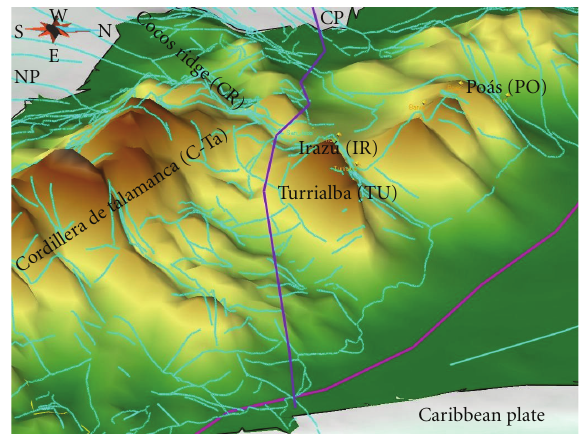
Figure 6: Perspective view onto the research area in Central America with some emphasis on the seafloor bathymetry and the trench. Looking along the trench o ff shore Central America in northwestern direction, in addition to the high-resolution SRTM3 topography dataset [28], we use also a lower-resolution ETOPO2v2 topography grid [39]. It surrounds the research area located inside the red bounding box covering Costa Rica, Nicaragua, and the complex oceanic floor with the incoming Cocos Ridge from southwest. The area is built by the northern portion of the Nazca plate in the south, the Cocos plate in the west, and the Caribbean plate in the east using an exaggeration of 1 : 8.